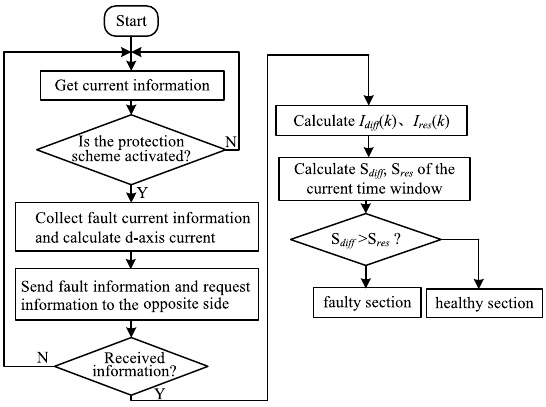
Fig. 7 Flow chart of the protection